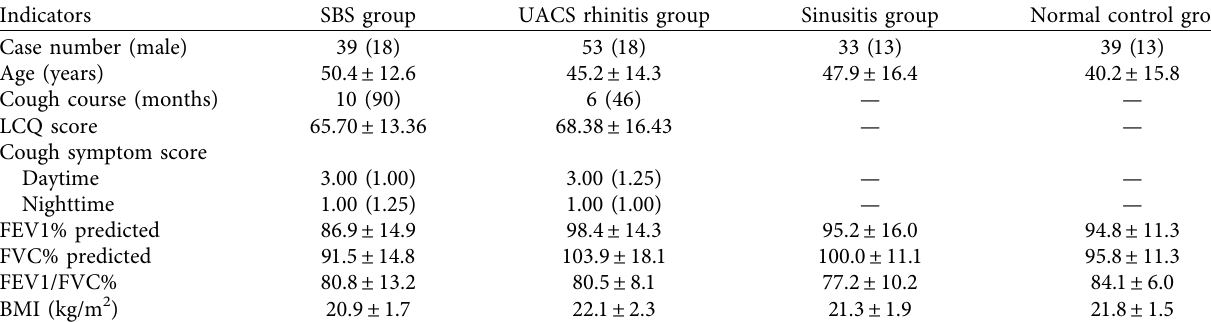
Table 1: General information for each group.